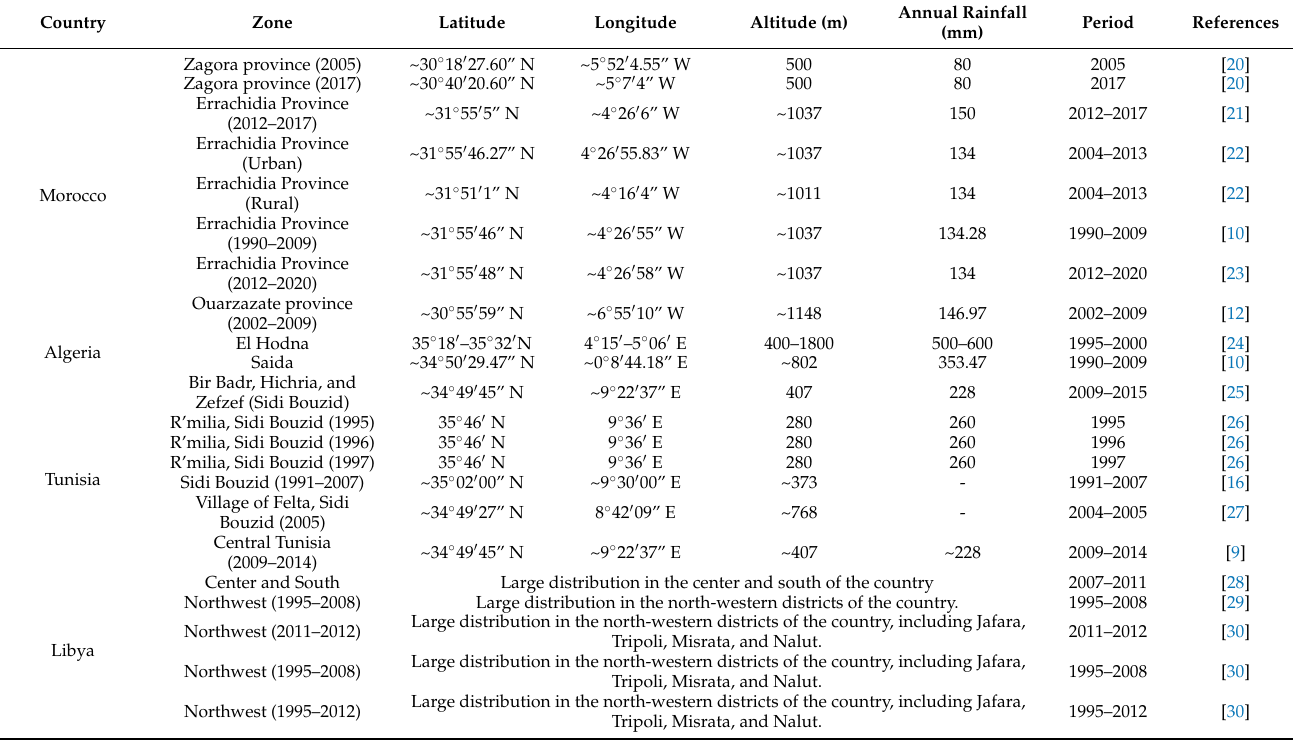
Table 1. Geolocalization of sites whose monthly data of ZCL cases in the North African countries are published. The geographic information includes the latitude, longitude, and altitude (m); for the sites without geographic data, the symbol ‘~’ was used, and the approximate values were estimated from Google Earth.